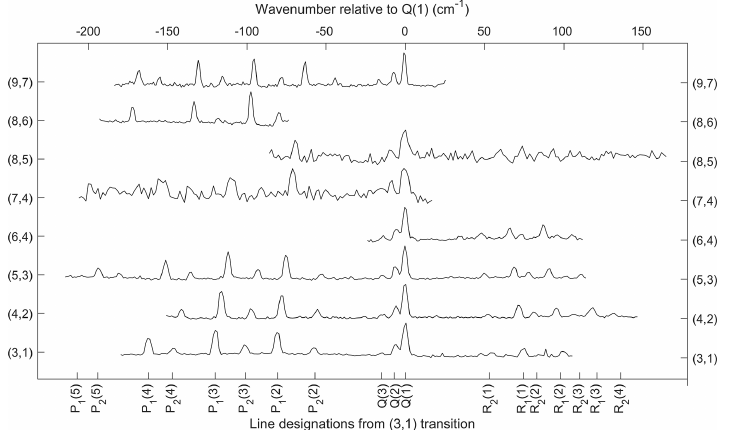
Figure 4. Spectra from the H, J, and K bands in wavenumbers relative to the Q(1) line in each band. The Q(1) lines of each spectrum are aligned. Line positions for the (3, 1) transition are shown.